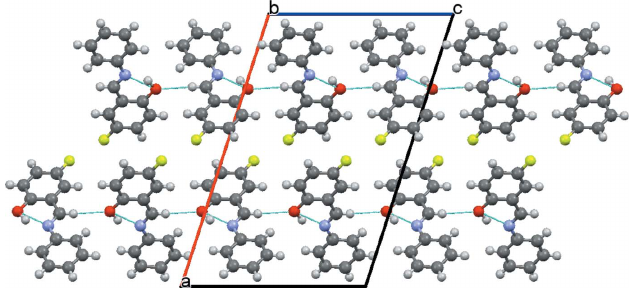
Figure 2 The crystal packing of the title compound, viewed down the crystal- lographic b axis. The hydrogen bonds (see Table 1) are shown as dashed